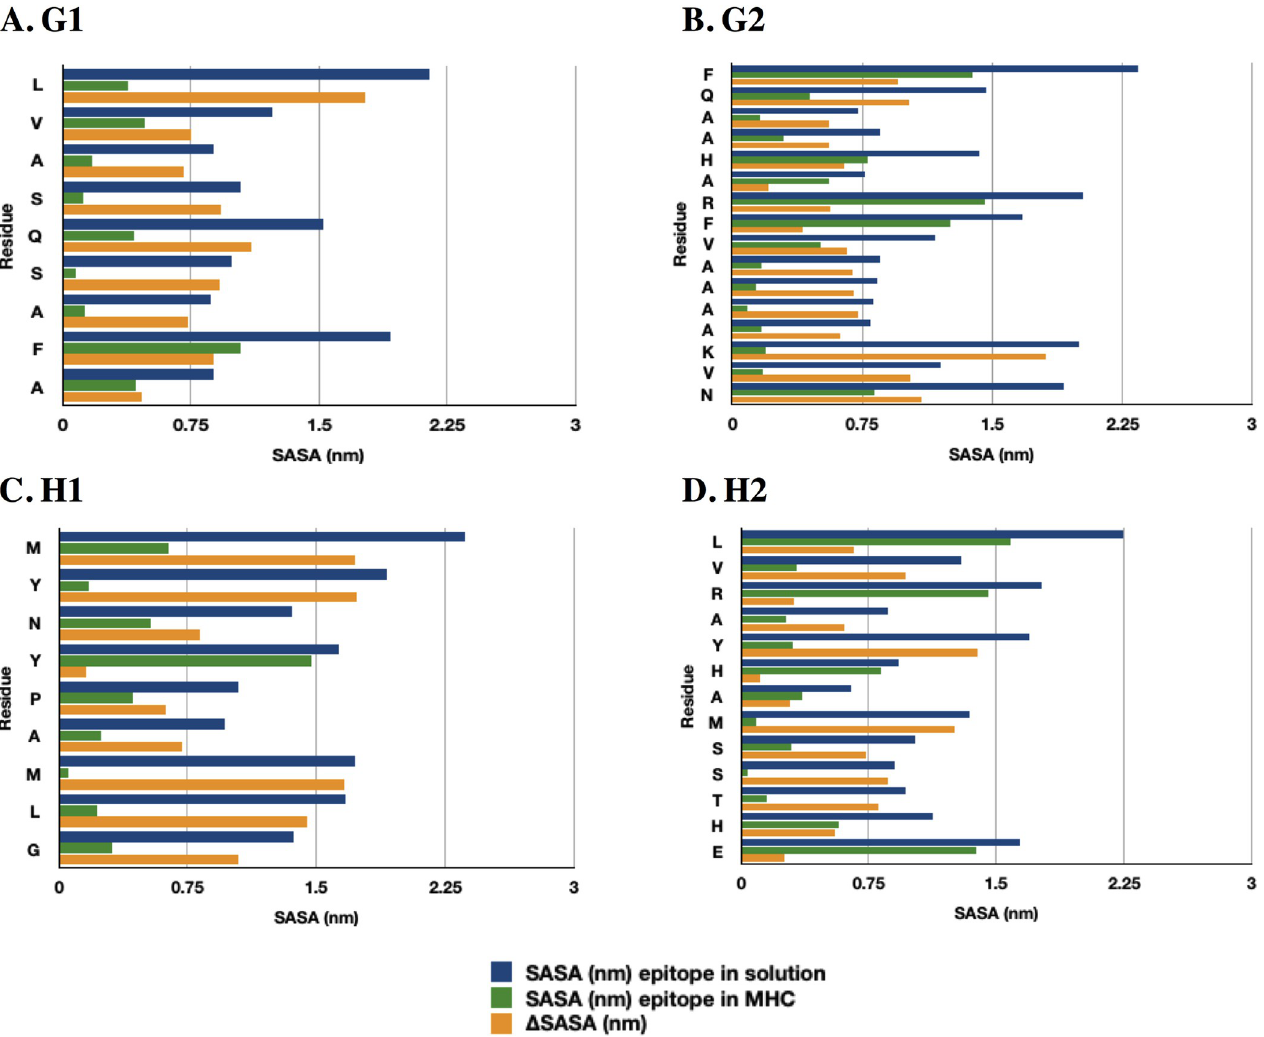
Fig 7. Solvent accessible surface area (SASA). (A). G1 epitope. (B). G2 epitope. (C). H1 epitope. (D). H2 epitope. The blue bars depict the SASA from the epitope in solution. The green bars depict the SASA from the epitope in the MHC. The yellow bars depict the Δ SASA, subtracting the SASA of the epitopes in solution from the SASA of the epitopes forming the complex.